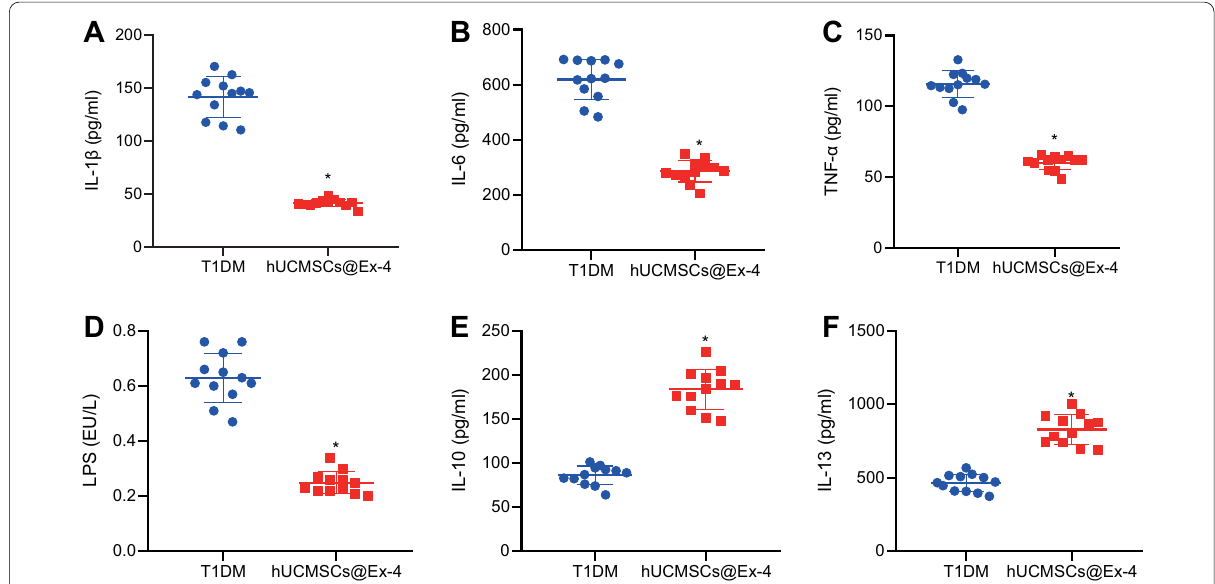
Fig. 5 hUCMSCs@Ex-4 reduces the secretion pro-inflammatory cytokines while increasing that of anti-inflammatory cytokines in the serum of T1DM mice. A Serum levels of IL-1β in T1DM mice treated with hUCMSCs@Ex-4 measured by ELISA. B Serum levels of IL-6 in T1DM mice treated with hUCMSCs@Ex-4 measured by ELISA. C Serum levels of TNF-α in T1DM mice treated with hUCMSCs@Ex-4 measured by ELISA. D Serum levels of LPS in T1DM mice treated with hUCMSCs@Ex-4 measured by ELISA. E Serum levels of IL-10 in T1DM mice treated with hUCMSCs@Ex-4 measured by ELISA. F, Serum levels of IL-13 in T1DM mice treated with hUCMSCs@Ex-4 measured by ELISA. * p < 0.05 vs. T1DM mice. n